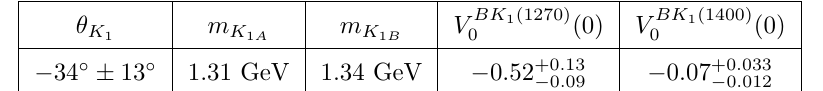
Table 12 . Values of the parameters in the vector form-factors (F.29) from [89].